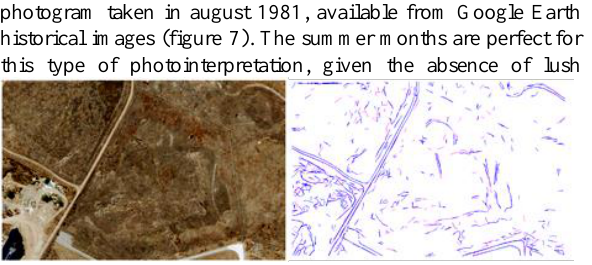
Figure 7. Aerial photograph (August 1981, Google Earth) and relative Lineament Extraction